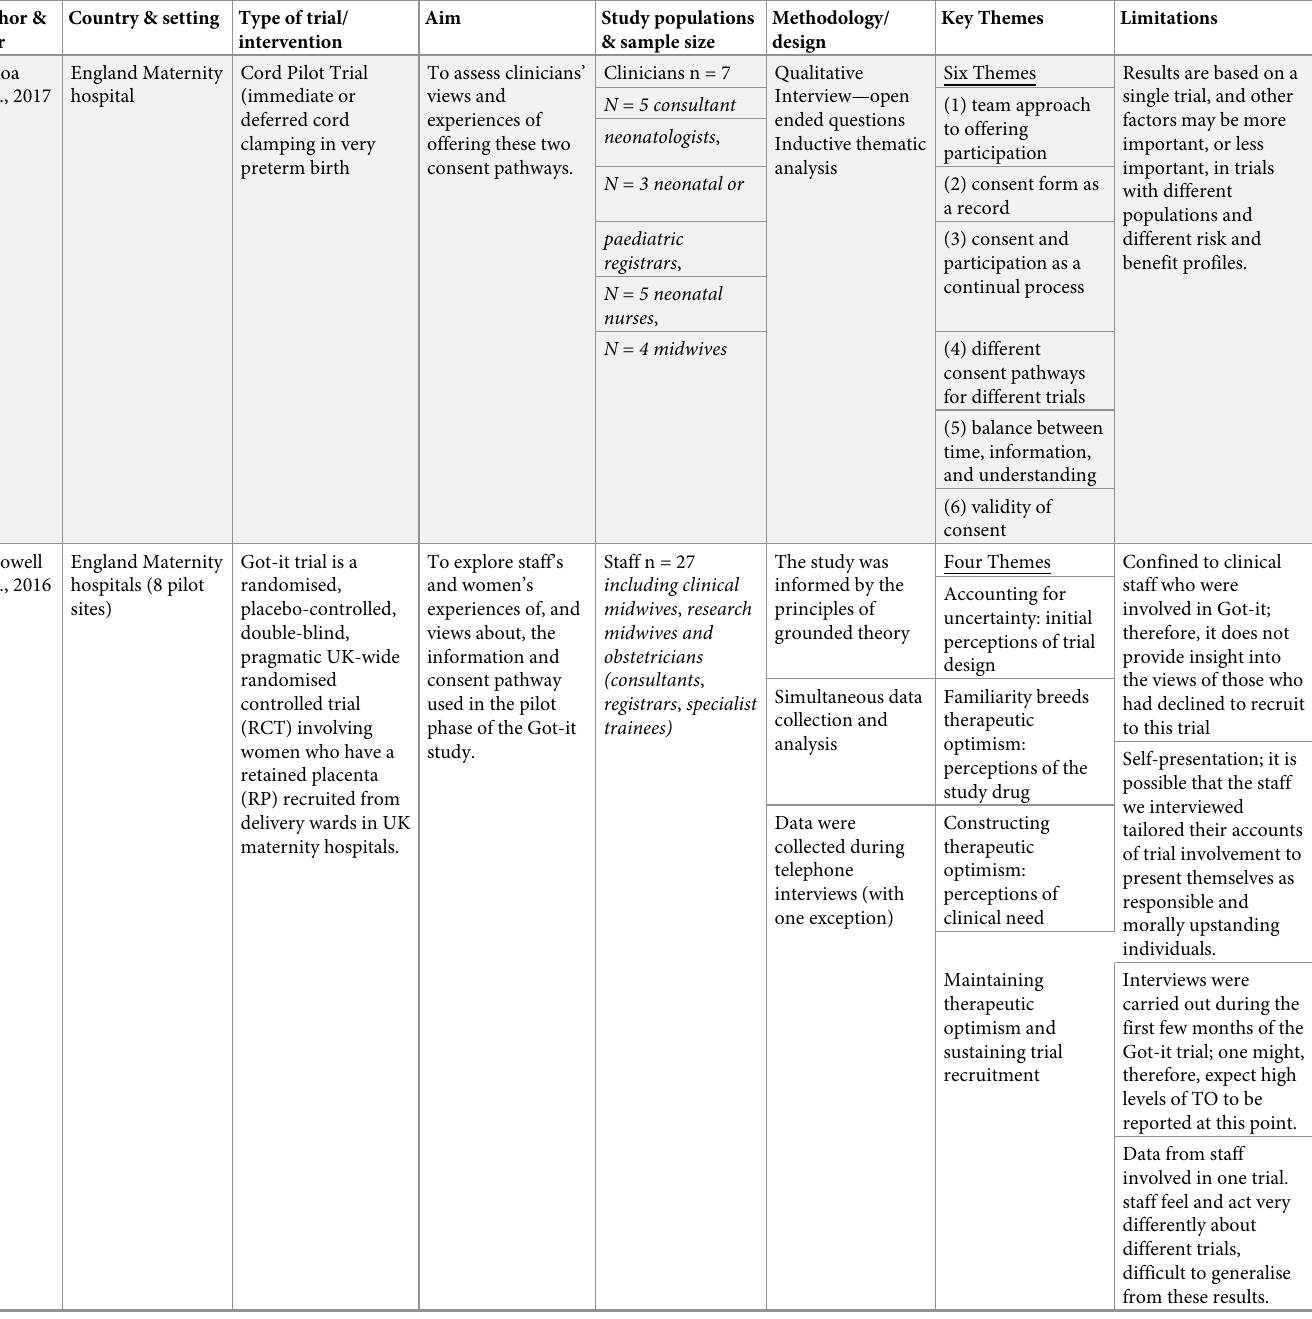
Table 1. Characteristics of included